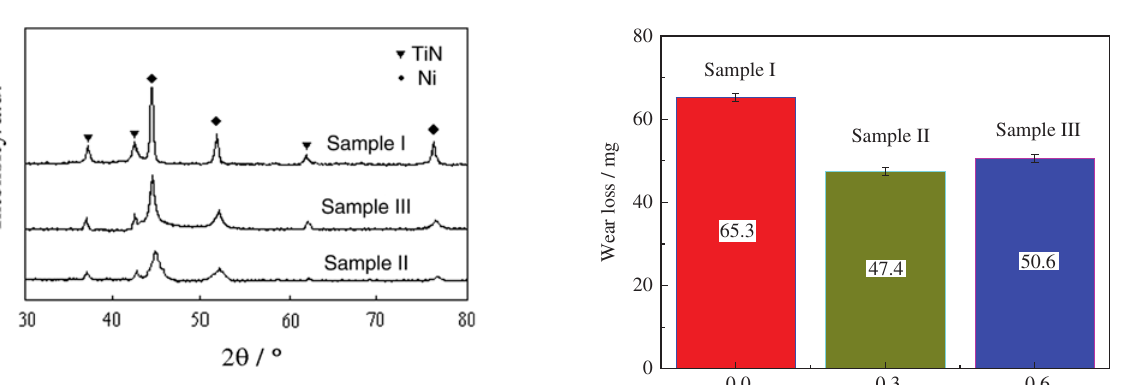
Figure 5: X-ray diffraction (XRD) patterns of Ni-TiN composite coatings deposited by pulse current (PC) and magnetic PC (MPC) deposition.